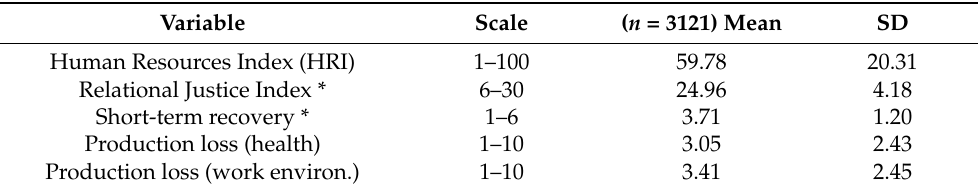
Table 2. Mean (SD) results for human resources index, relational justice index, short-term recovery, work environment-related production loss, and health-related production